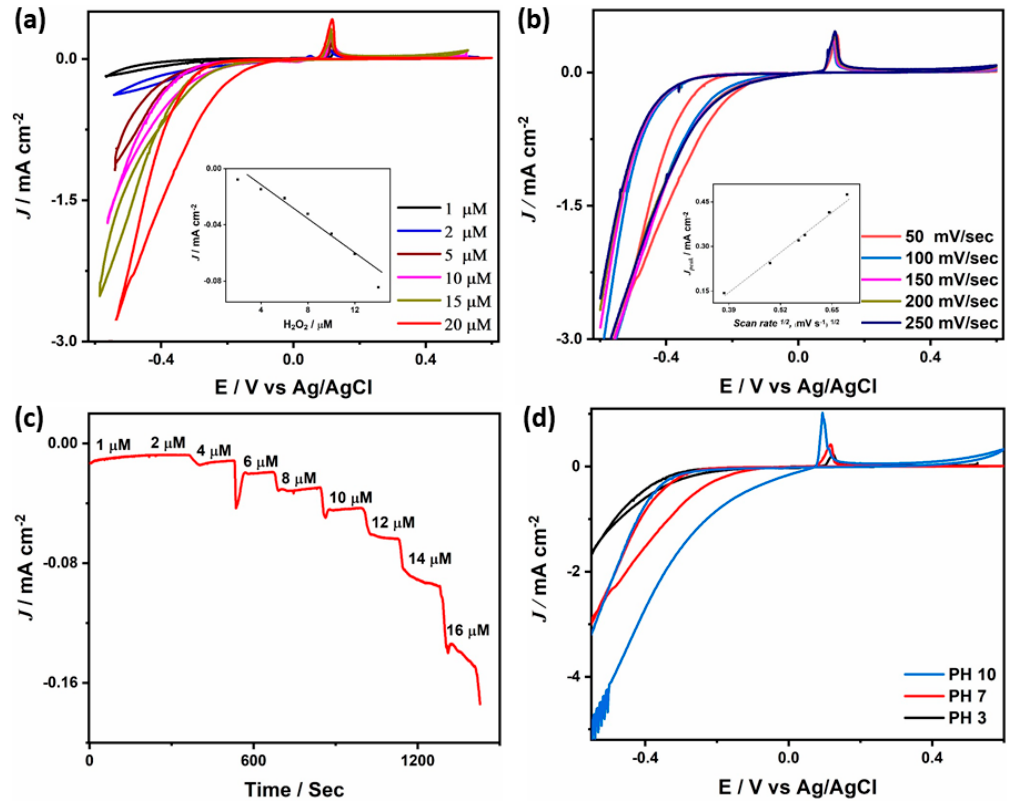
Figure 7. ( a ) CVs measured in an aqueous solution of (pH 7.4) containing di ff erent concetartion of H 2 O 2 at 50 mV s − 1 ( b ) CVs measured at di ff ret scan rates. The insets in ( a ) and in ( b ) show the plot of current versus H 2 O 2 concetration and current versus scan rates, respectively. ( c ) Chronoamperometric curve, ( d ) CVs measured in solutions with different pH values in the presence of 20 µ M H 2 O 2 at 50 mV s − 1 .